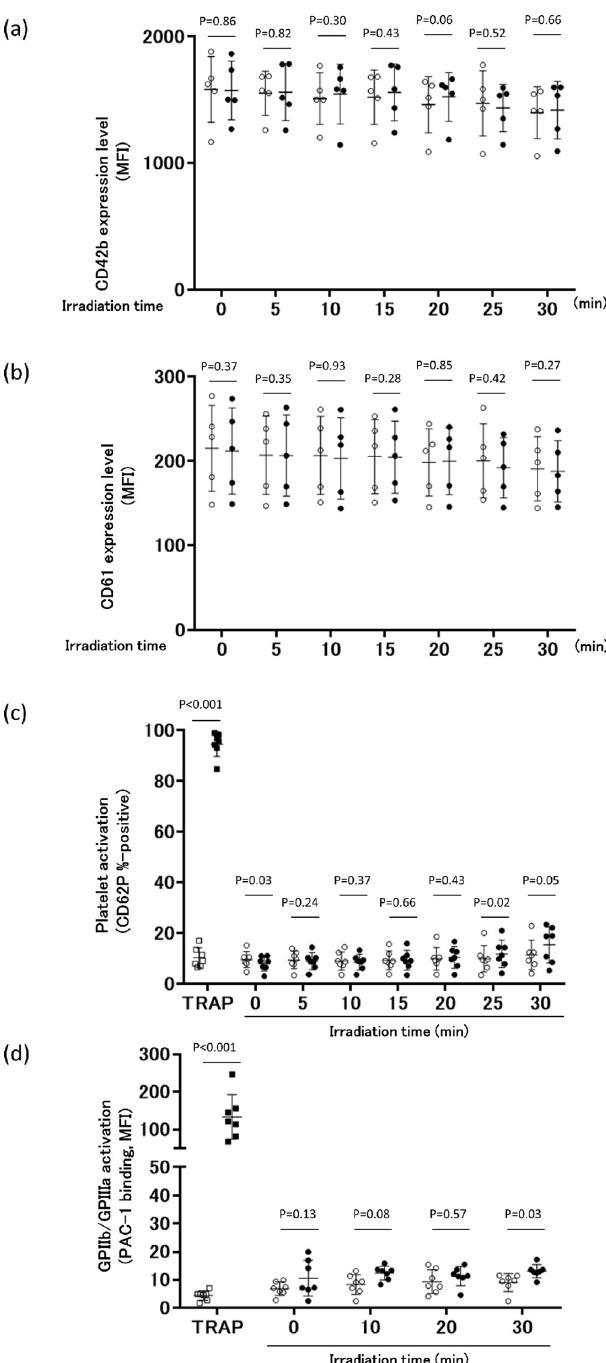
Fig 4. Effect of UV-LED irradiation on platelet surface molecules. Surface expressions of (a) CD42b, (b) CD61, (c) the activated form of GPIIb/IIIa, and (d) CD62P were measured. Five (a, b) and seven (c, d) independent experiments of the control (non-irradiated) and UV-LED-irradiated platelets are displayed as open and closed circles, respectively. Mean values ± SD are shown as one long and two short horizontal bars. (a, b, d) Based on the mean absorbance of PC samples, irradiation times of 0, 5, 10, 15, 20, 25, and 30 min correspond to fluence values of 0, 4.6, 9.2, 13.9, 18.6, 23.5, and 28.5 mJ/cm 2 , respectively. (c) Irradiation times of 0, 10, 20, and 30 min correspond to fluence values of 0, 9.1, 18.3, and 27.7 mJ/cm 2 ,